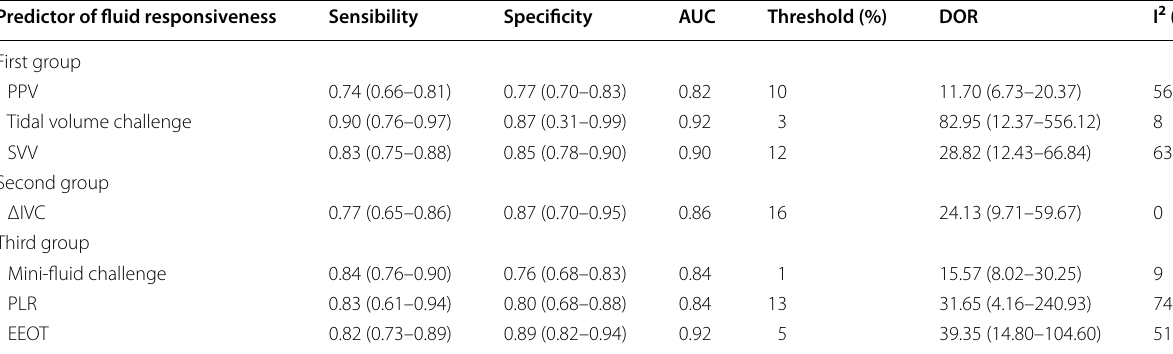
Table 3 Operative performance of predictors of fluid responsiveness